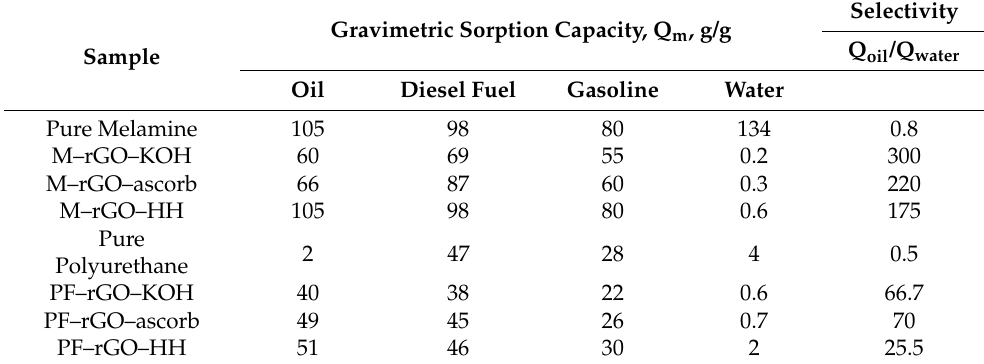
Table 1. The results of sorption experiments of studied samples.